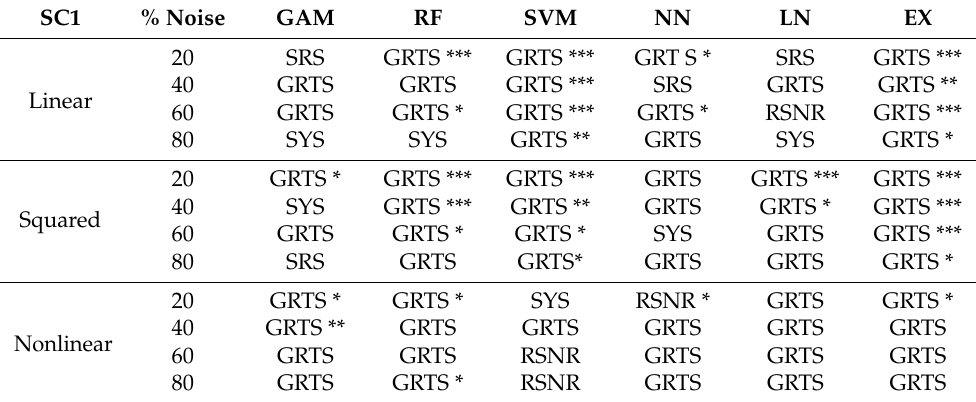
Table 1. Design with smallest average root mean squared error (RMSE) across iterations by re- sponse surface distribution (SC1), fully-specified modeling technique, and amount of introduced noise (%